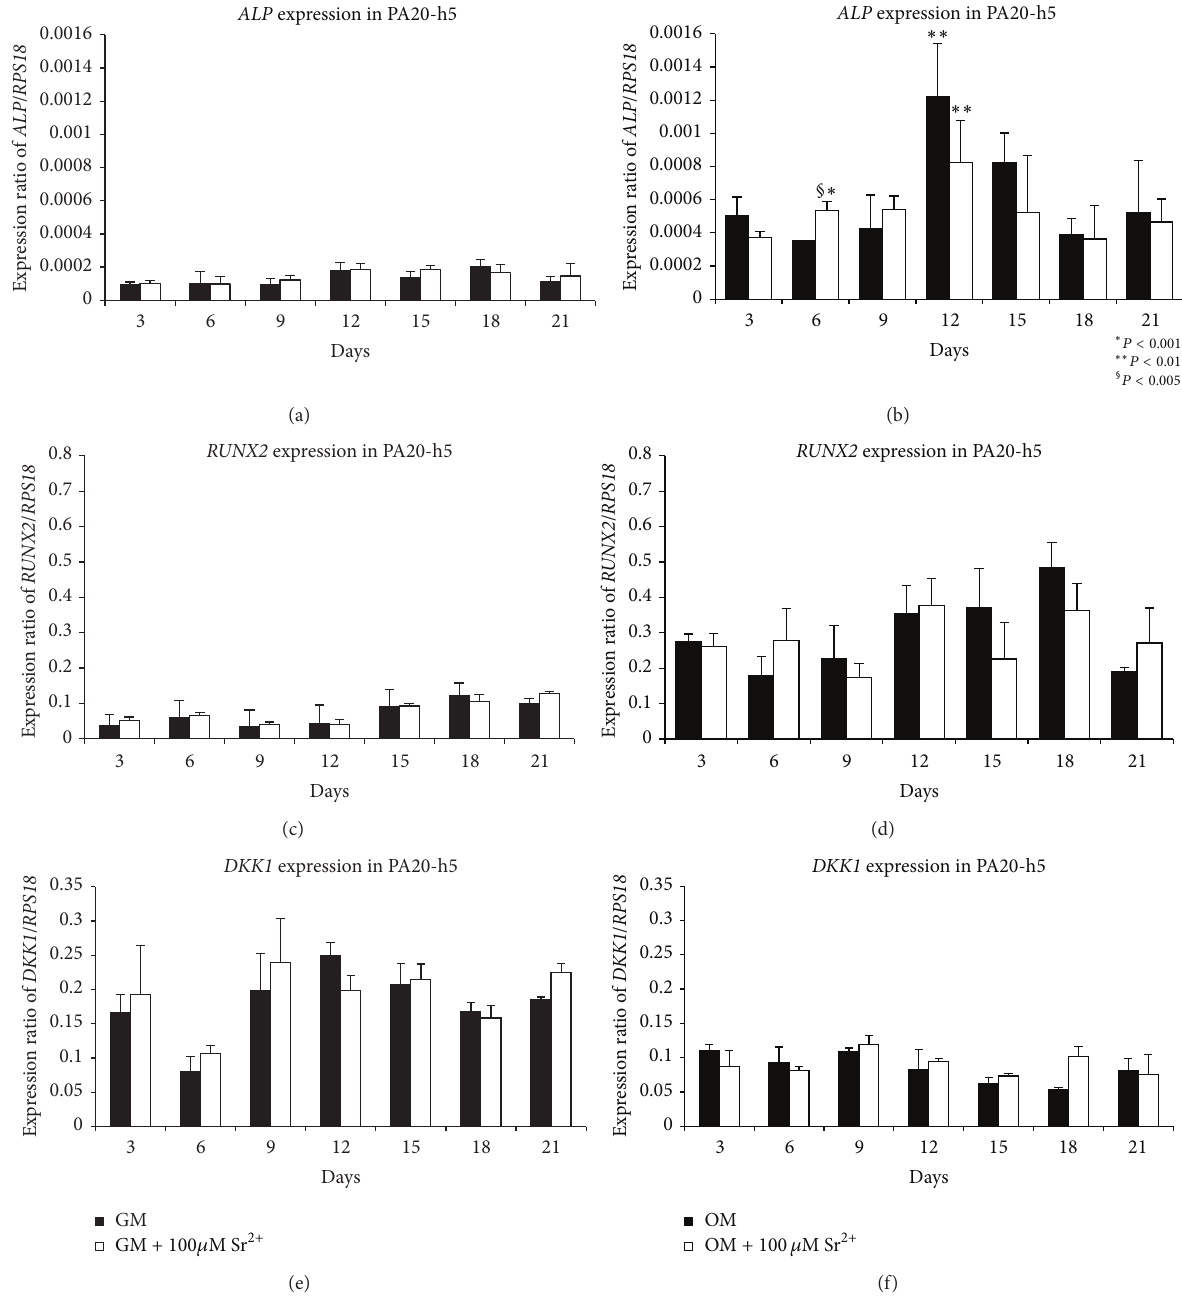
Figure 5: Analysis of gene expression of ALP ((a), (b)), RUNX ((c), (d)), and DKK1 ((e), (f)) in PA20-h5 from 3 to 21 days. Culture in medium GMandGMcontaining100 𝜇 MSr 2+ ((a),(c)and(e)).CultureinmediumOMandOMcontaining100 𝜇 MSr 2+ ((b),(d),and(f)).Experiments are carried out in triplicate and are representative of three different